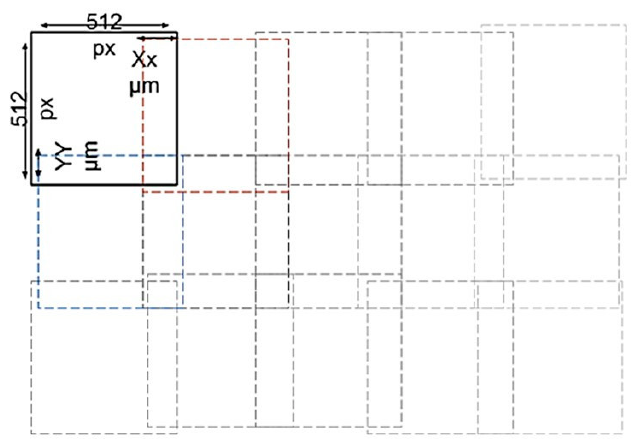
Figure 2. Scheme of how the imaging is performed using the motorized light microscope. The pictures are taken in a 512 × 512 px section, generating overlapping areas to obtain a macro image without blemishes in these areas.